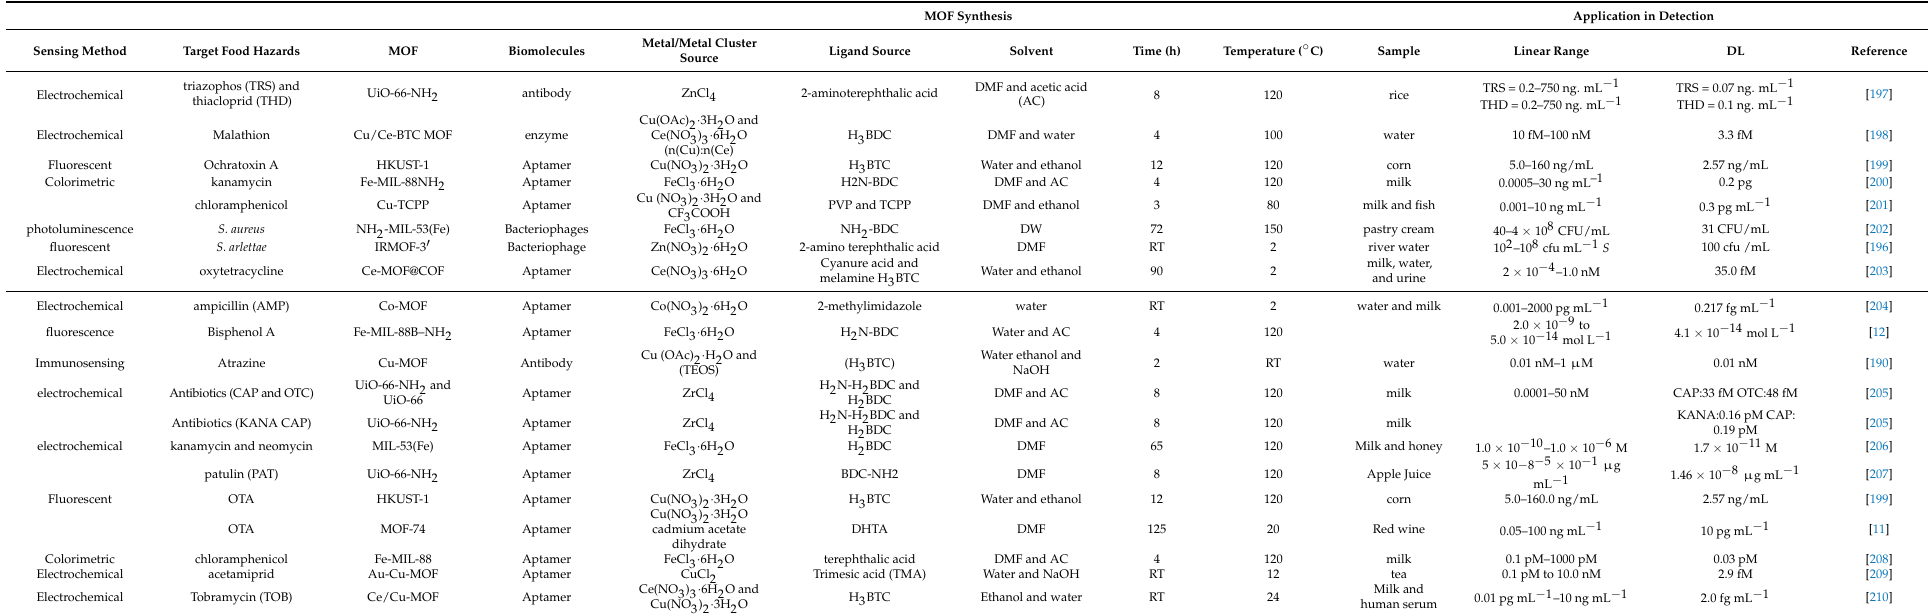
Table 4. Sensing application of the MOF-based biosensing method for food safety